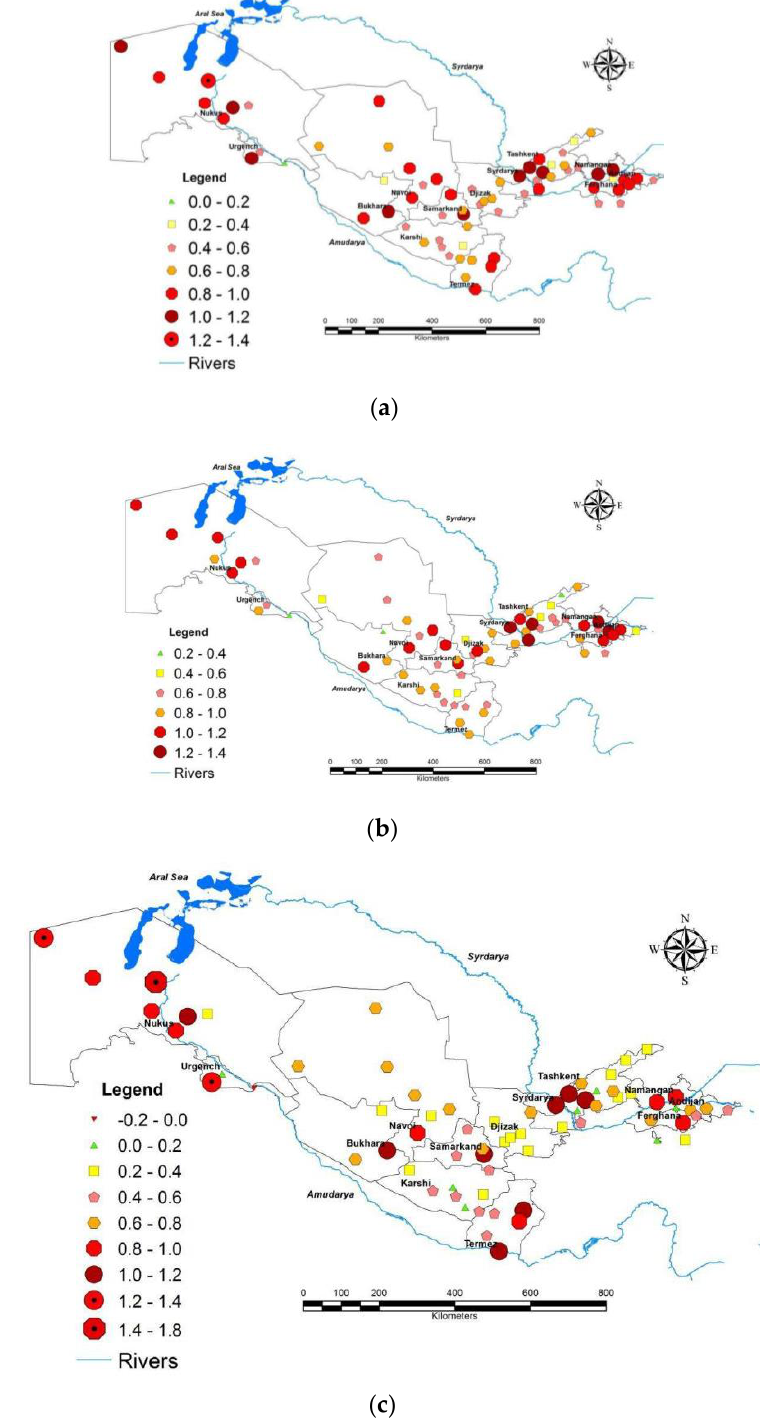
Figure 4. Average long-term air temperature variations in Uzbekistan for the 1991–2016 period compared to the baseline 1961–1990 period (in °C). ( a ) Annual, ( b ) cold half-year, ( c ) warm half-year.